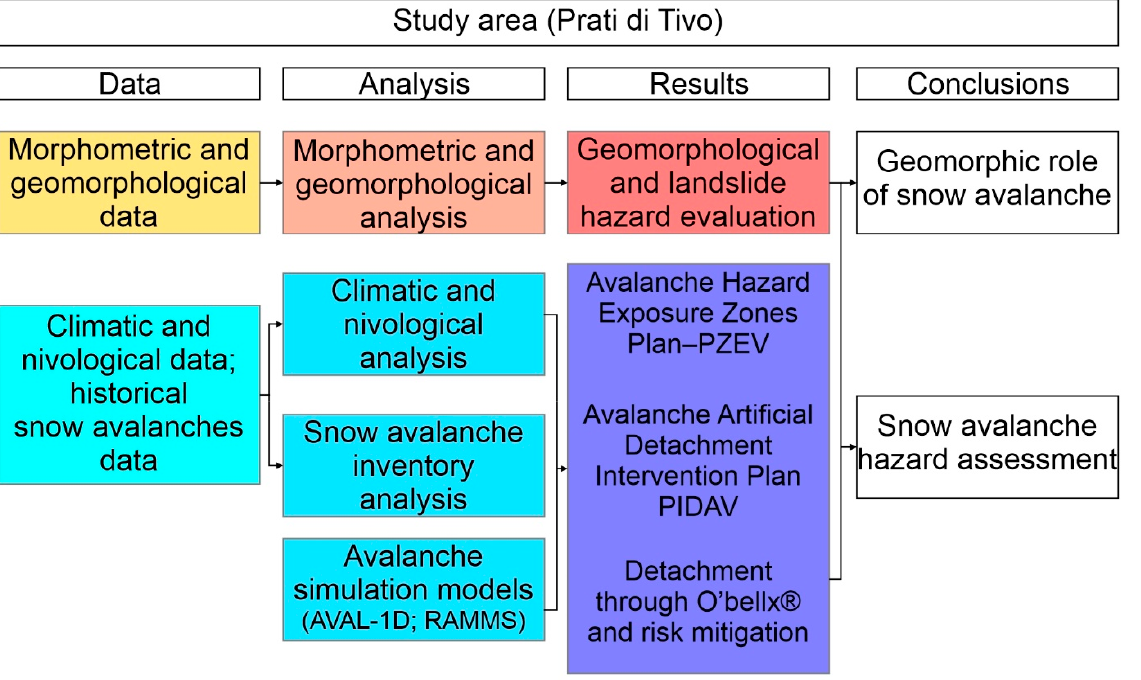
Figure 3. Schematic flowchart diagram showing the main methodological